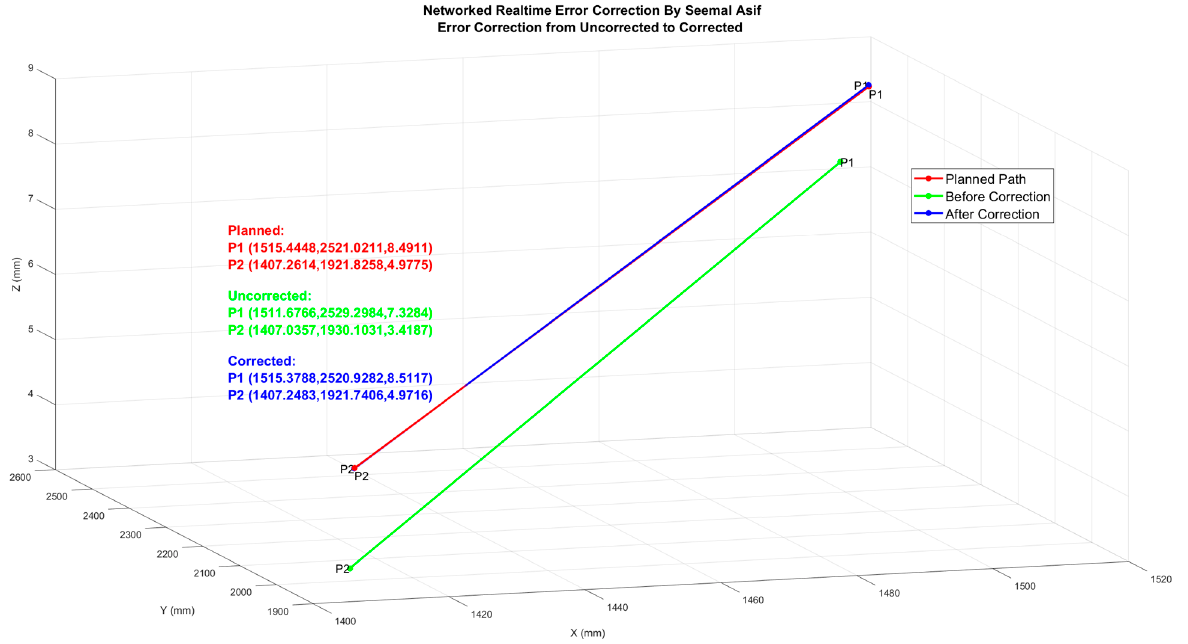
Figure 9. Error correction between two points. Points p1 and p2 are the same points as reported by the robot, measured by the tracker, and corrected by NRTEC. “Planned” in red indicates the planned path that forms the robot trajectory, “Uncorrected” are the points where the robot reaches and “Corrected” are the same points which were corrected by NRTEC after receiving the information from the Leica Tracker (AT901) and sent back to the robot. The point selected is on the first instance where the system is able to be in the close proximity to the planned path. The system is further able to correct itself and achieve the correction within 0.02 mm.